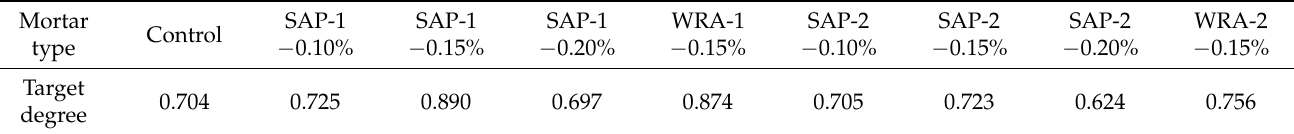
Table 5. Target degree of